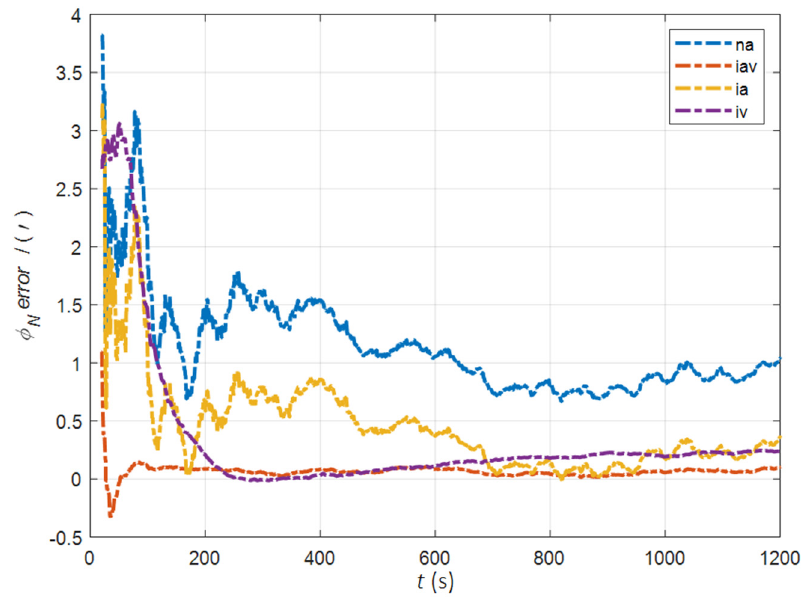
Figure 7. The error curves of φ N in the cases of the initial misalignment angles [ 5 ◦ 5 ◦ 20 ◦ ] T .